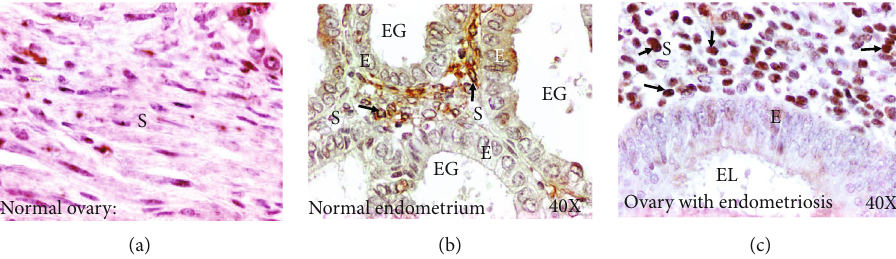
Figure 2: Expression of CD10 by the endometrial stromal cells in normal ovaries and ovary with endometriosis. (a) Section of a normal ovary. No CD10-positive stromal cells are seen. (b) Section of an endometrium showing stromal cells expressing CD10. However, epithelial cells in the endometrial glands were negative for CD10 expression. (c) Section of an ovary with endometriosis showing intense expression for CD10 by many stromal cells. Similar to normal endometrium, epithelial cells in endometriotic lesions (EL) did not show CD10 expression. E=epithelium; EG=endometrial glands; EL =endometriotic lesion; S =stroma; 40x =magni fi cation. Arrows indicate examples of immunopositive CD10